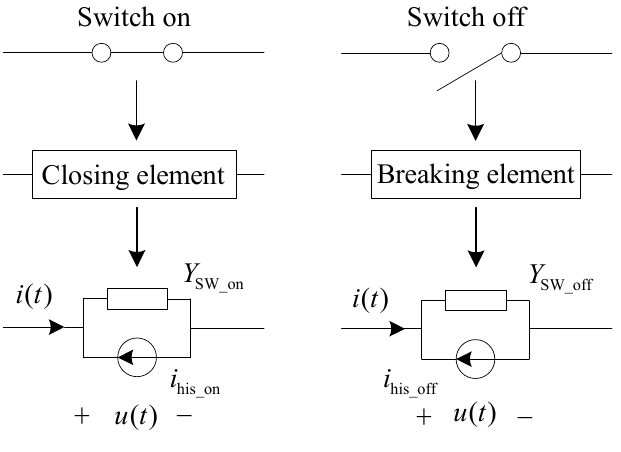
Figure 8. The GST Figure 8. The GST model.